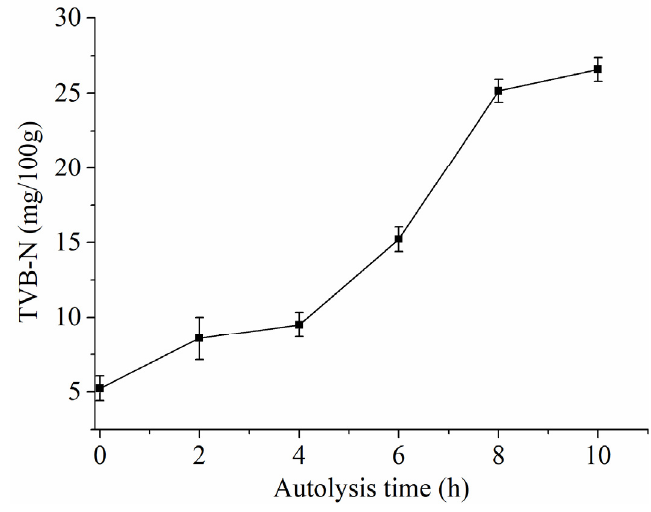
Table 2. The concentrations of proximate composition in SH (wet basis, %).